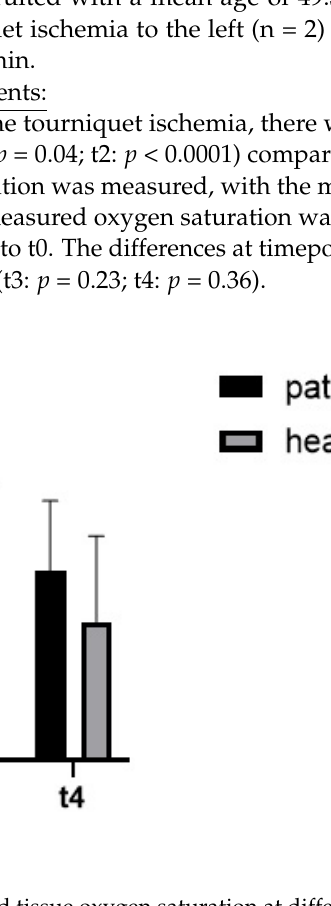
Figure 4. Mean values of measured tissue oxygen saturation at different timepoints.